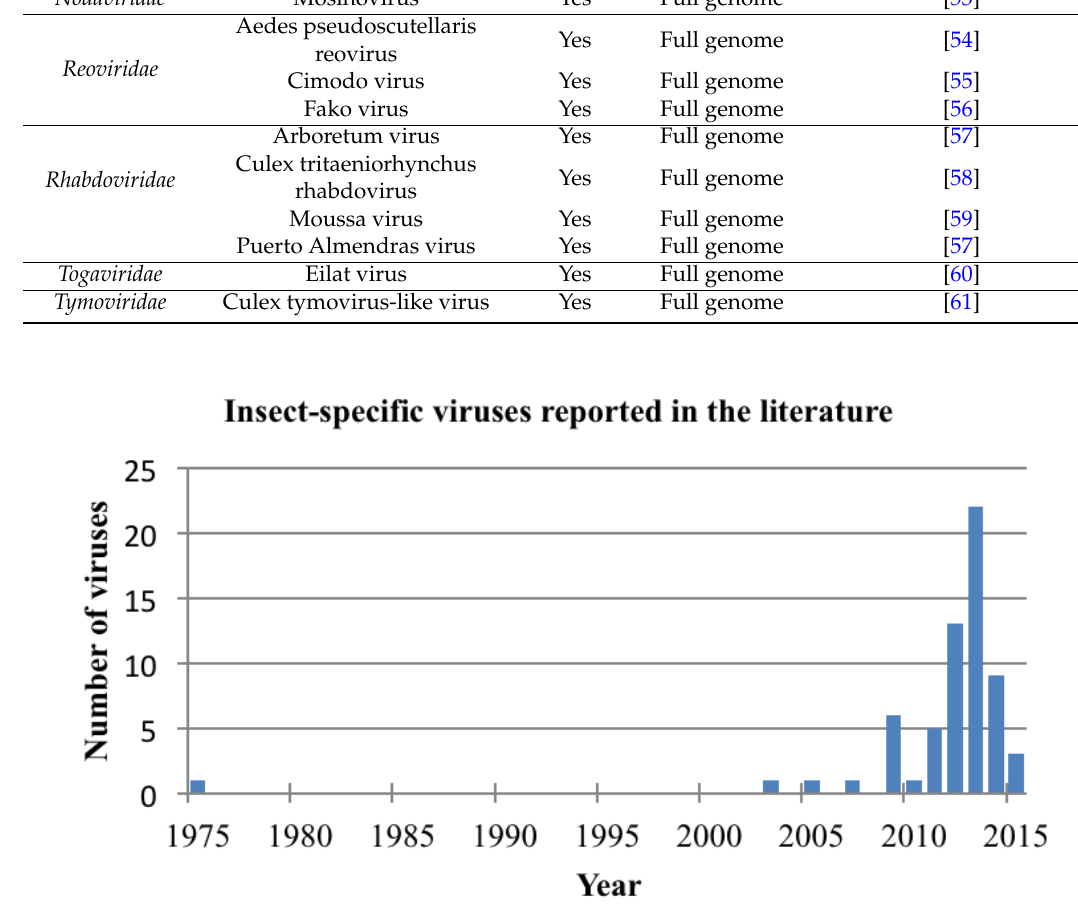
Figure 1. Timeline demonstrating dramatic increase in insect-specific virus discovery.